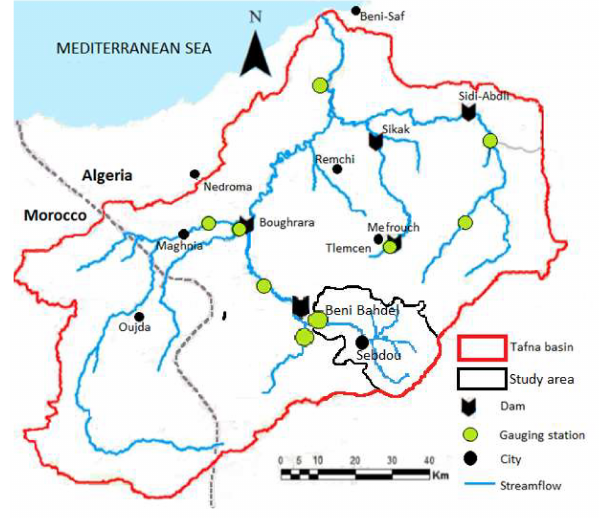
Figure 2. Location of the Wadi Sebdou in the Tafna